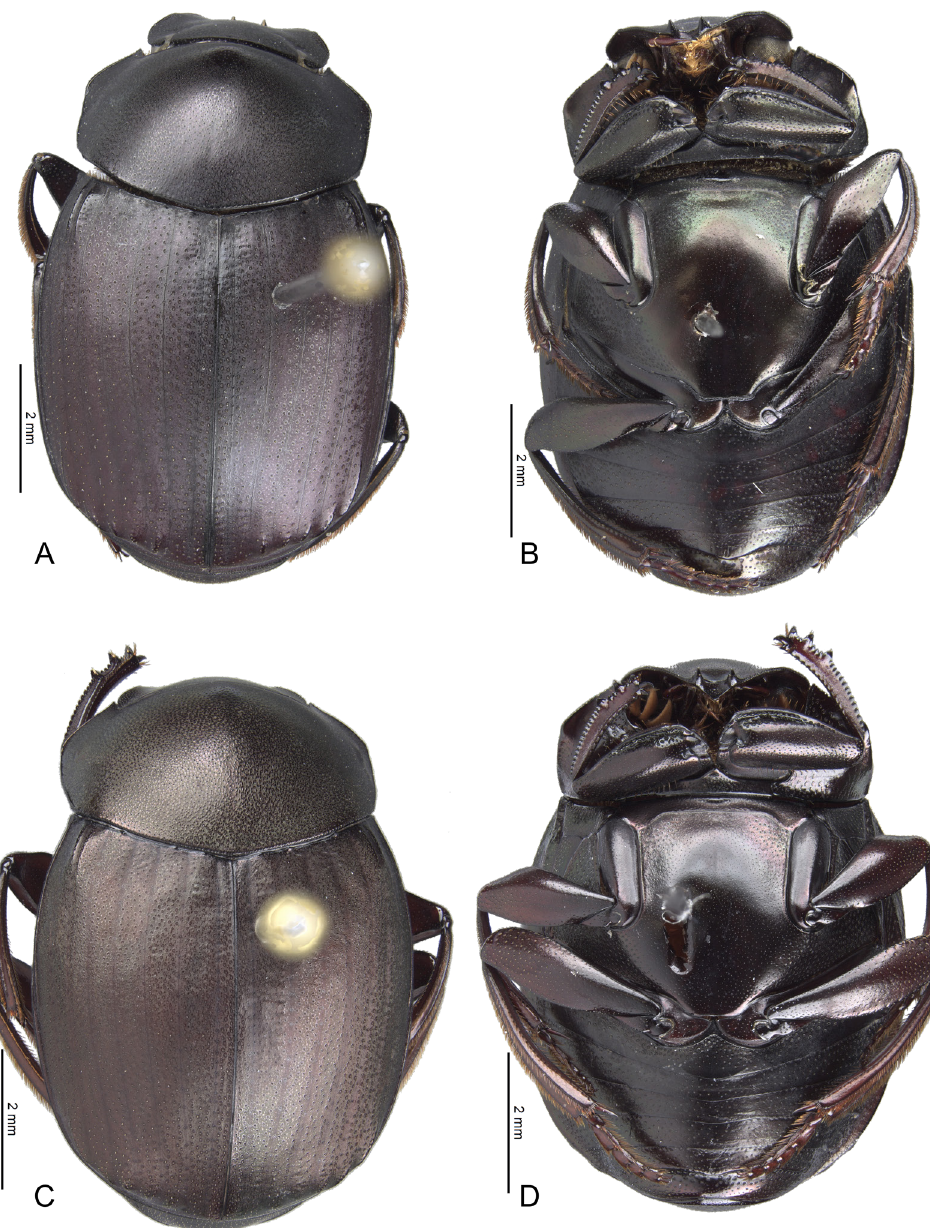
Fig. 9. Habitus A, C and ventral view B, D of the only two females known of the gilli species group. A – B . Paratype of Deltochilum gilli González-Alvarado & Vaz-de-Mello, 2021. C – D .